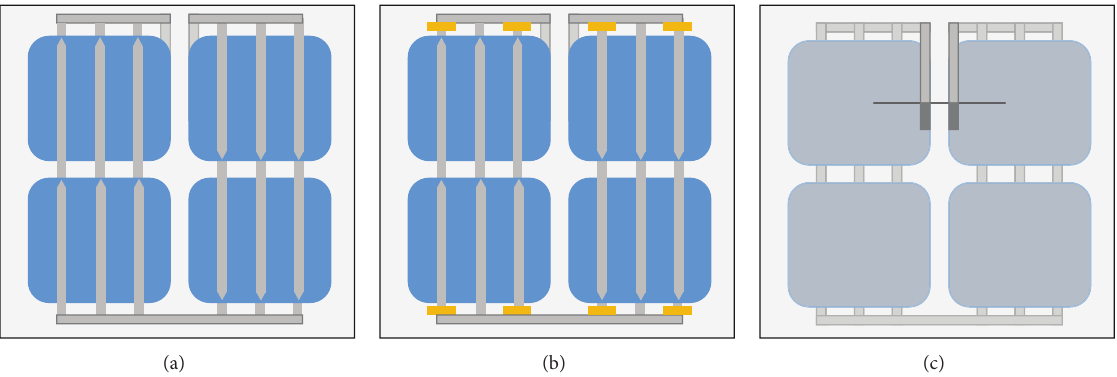
Figure 5: Schematic of the PV modules: (a) front side of the sample without Al, (b) front side of the sample with Al, and (c) backside of both of the